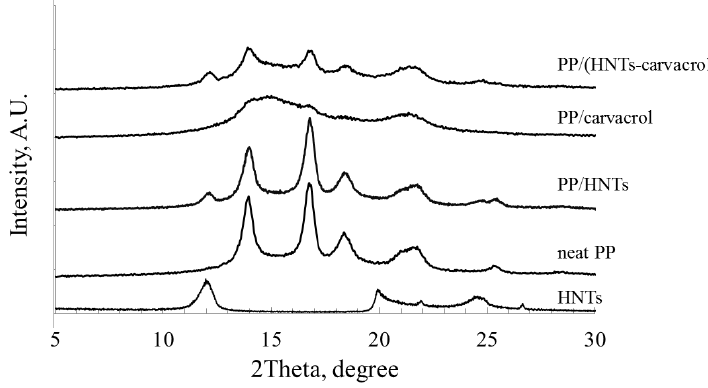
Figure 5. WAXS diffractograms of neat HNTs and all films. The diffractograms are offset along the Y -axis, for clarity.